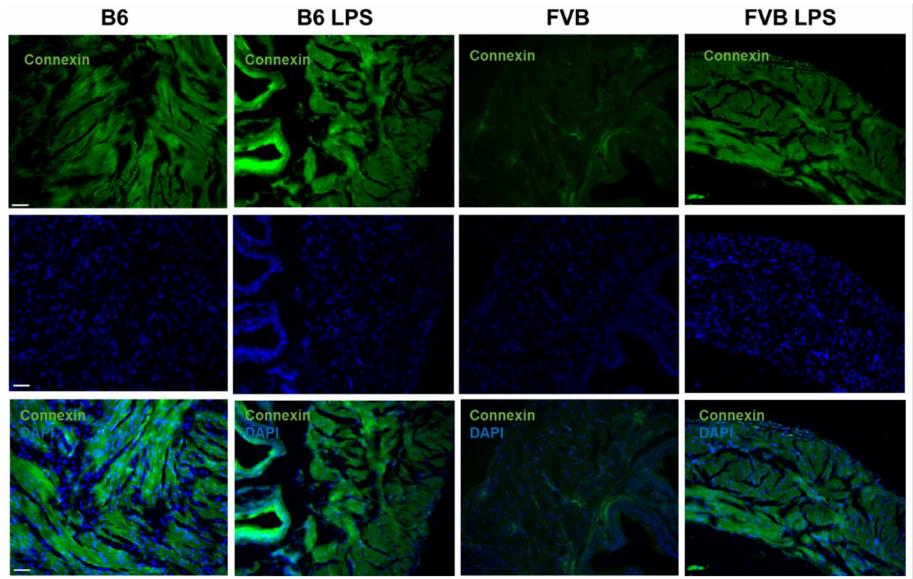
Figure 7. Connexin staining (green, first row) showing gap junctions in the frozen sections from